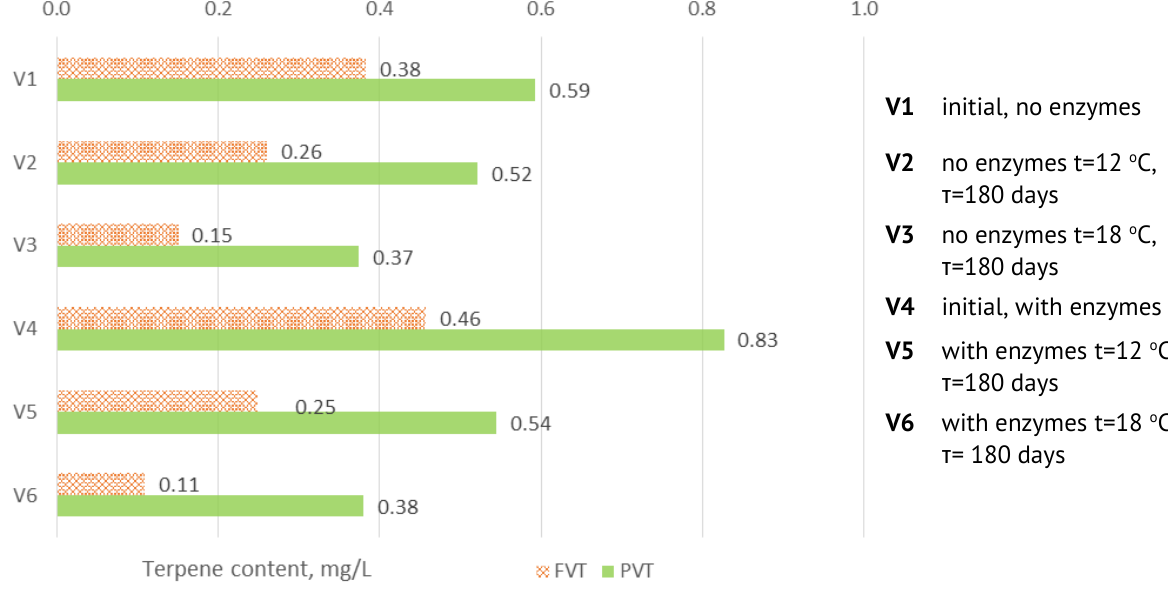
Figure 2. Variation of terpene compounds during storage at different